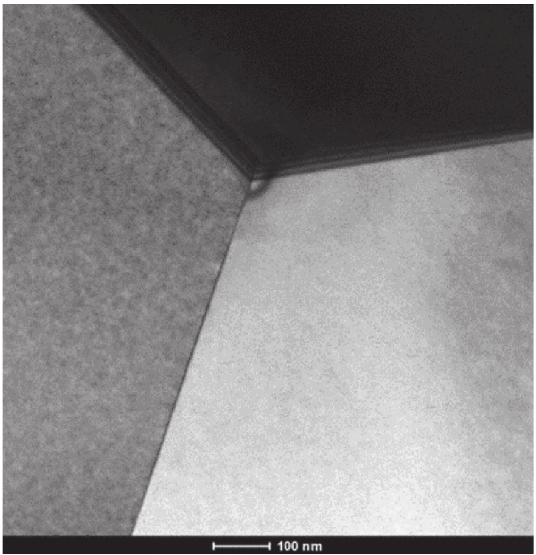
Figure 1: TEM micrographs of un-irradiated Hastelloy